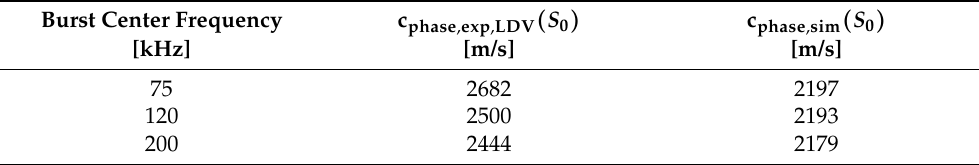
Table 3. Phase velocity identification for the fundamental S 0